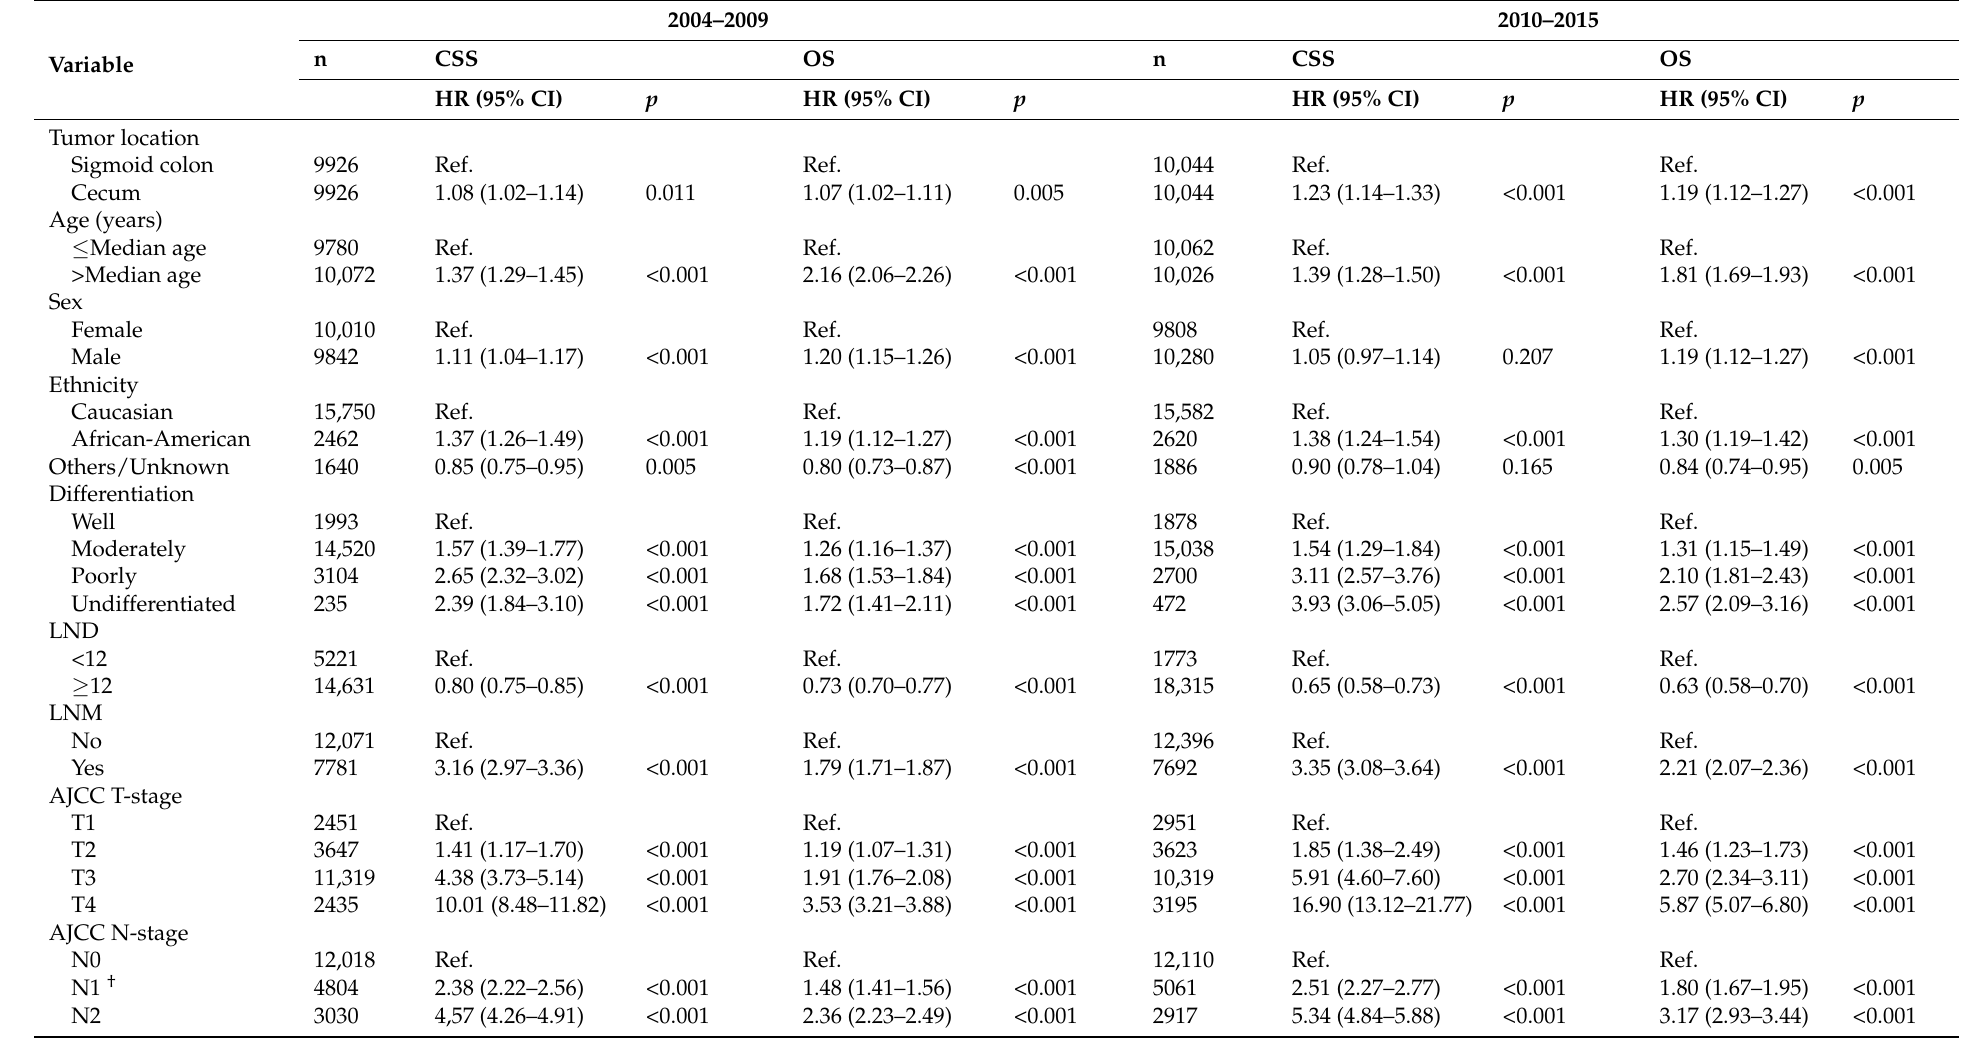
Table 4. Univariate Cox regression analysis of prognostic factors after propensity score matching for patients diagnosed with cecum or sigmoid